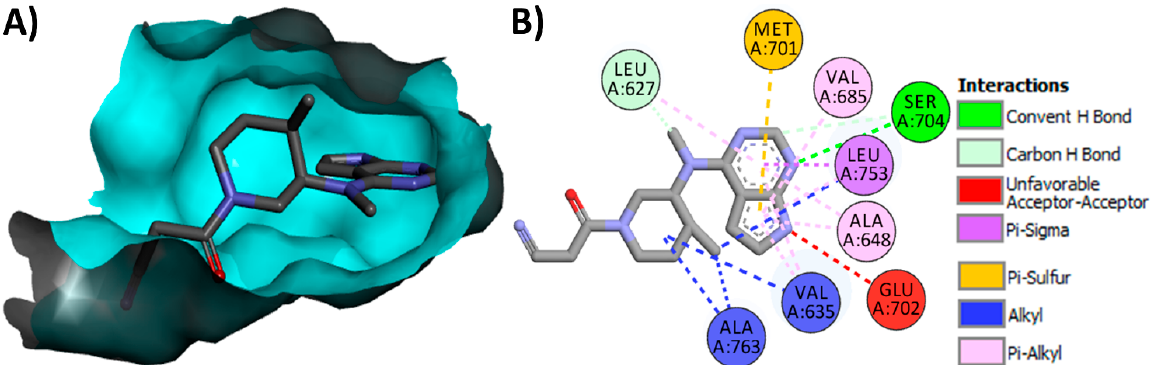
Figure 64. Binding modes of tofacitinib (shown as sticks) into the PRK1 catalytic domain (pdb: 4OTI): ( A ) 3D binding mode, receptor shown as a hydrogen bond surface; ( B ) 2D binding mode showing different types of interactions with PRK1 catalytic domain; hydrogen atoms were omitted for clarity; this figure was generated using Discovery Studio Visualizer (V16.1.0.15350).